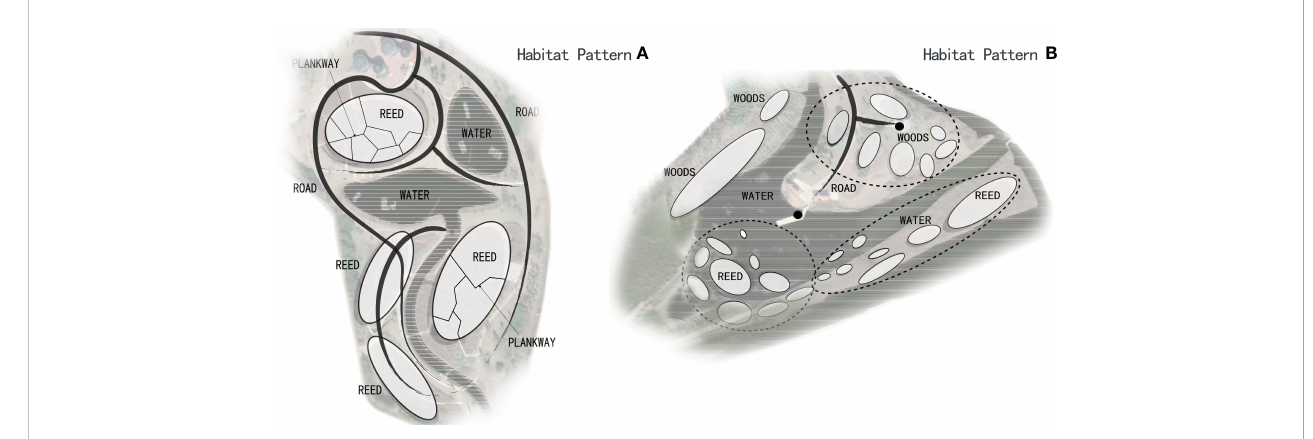
FIGURE 2 The diagram of Habitat Pattern A and Habitat Pattern B in the